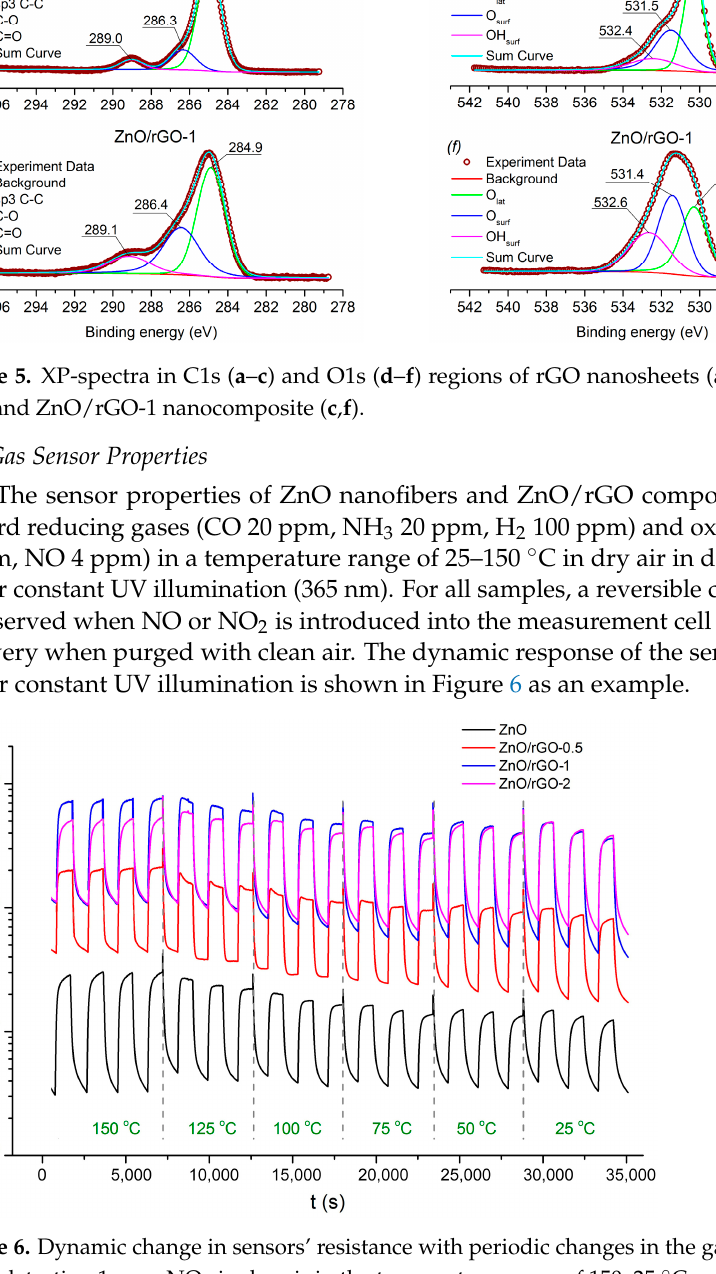
( d ) Figure 7. Sensor signal of ZnO nano fi bers and ZnO/rGO composites when detecting reducing gases CO, NH 3 , H 2 and oxidizing gases NO and NO 2 in dark conditions ( a , b ) and under constant UV illumination ( c , d ) at T = 25 °C ( a , c ) and T = 150 °C ( b , d ).